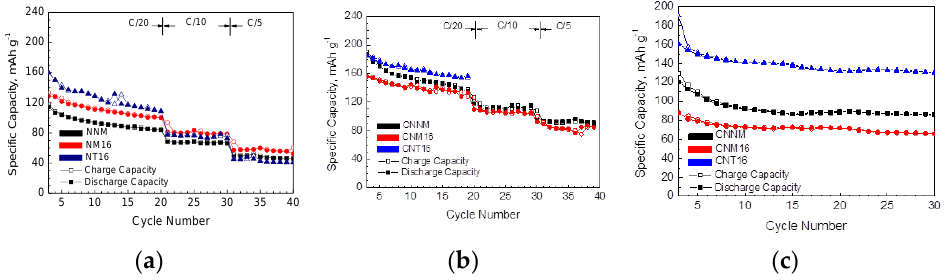
Figure 8. Specific capacity, cycling stability and rate capability for NNM, NM16 and NT16 ( a ) and their CeO 2 -treated analogues CNNM, CNM16 and CNT16 ( b ) in lithium-ion cells worked between 1.5 and 4.5 V. The cycling stability for CNNM, CNM16 and CNT16 at a rate of C/2 between 1.5 and 4.8 V ( c ).